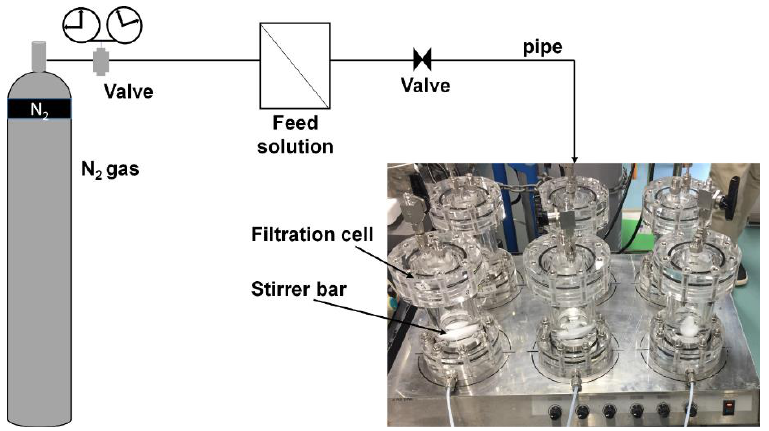
Figure 1. Setup of the desalination test in this study.